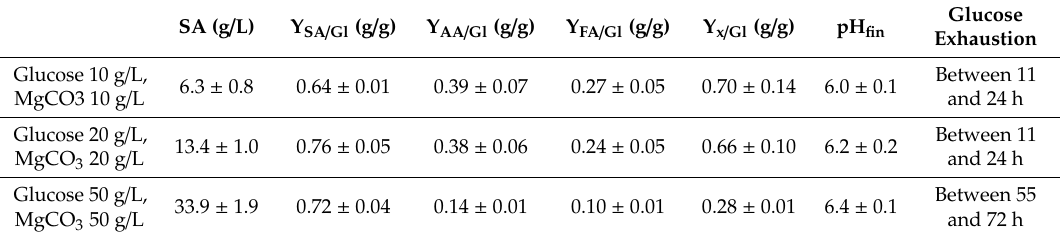
Table 3. Growth of A. succinogenes in bottles on MH medium with 10, 20 and 50 g / L of glucose and MgCO 3 , respectively. Experiments were performed at least in duplicate. pH fin indicates the pH measured when all the carbon source was consumed. SA (g / L) Y SA / Gl (g / g) Y AA / Gl (g /